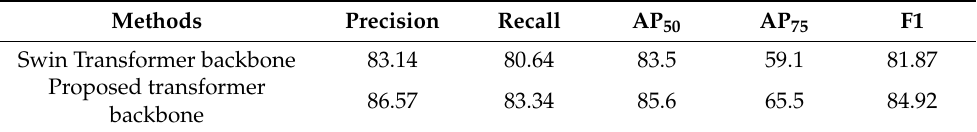
Table 1. The comparison of proposed transformer backbone with the Swin